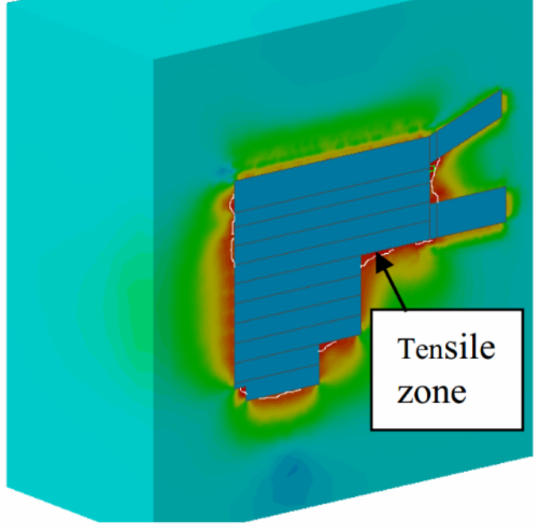
Figure 11. Tensile zone of longitudinal cross-section when considering dynamic effects.